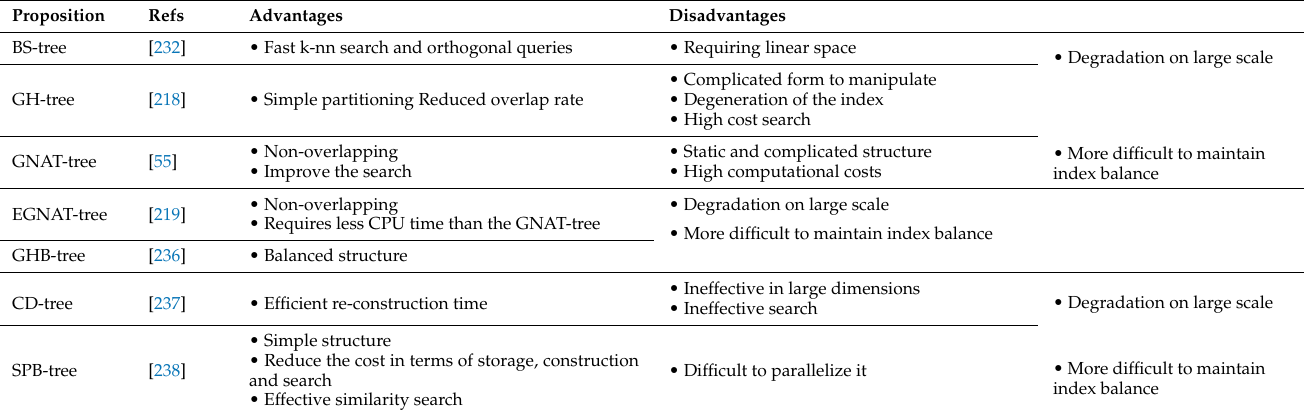
Table 14. Summary of advantage and disadvantage of metric indexing techniques based on hyper- plane